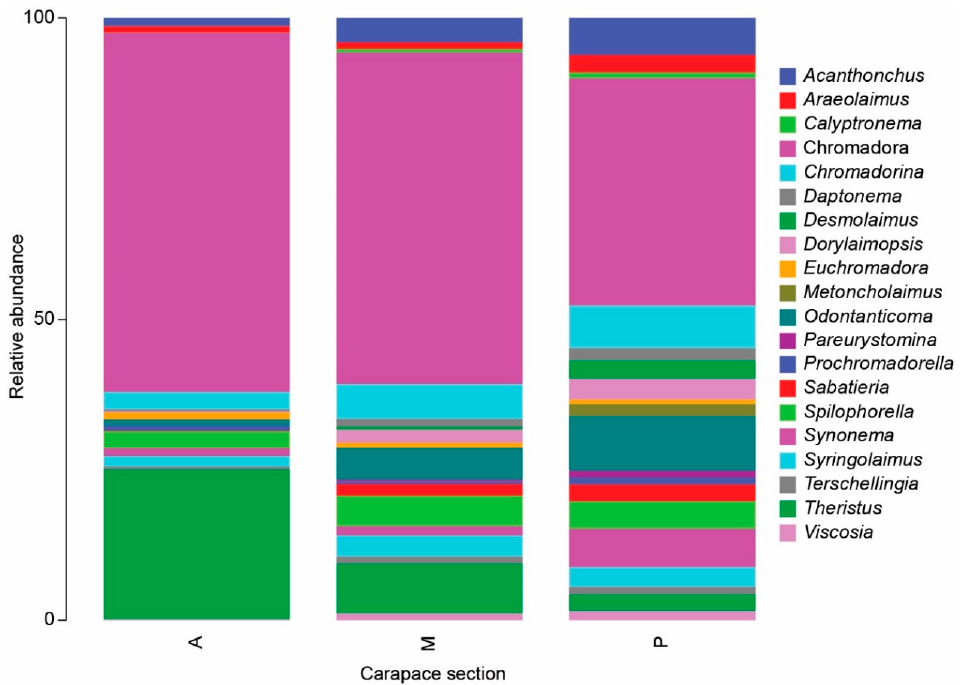
Figure 5. Relative abundance of nematode genera per carapace section. A: anterior section, M: middle section, P: posterior section. Only the 20 most abundant genera are shown.